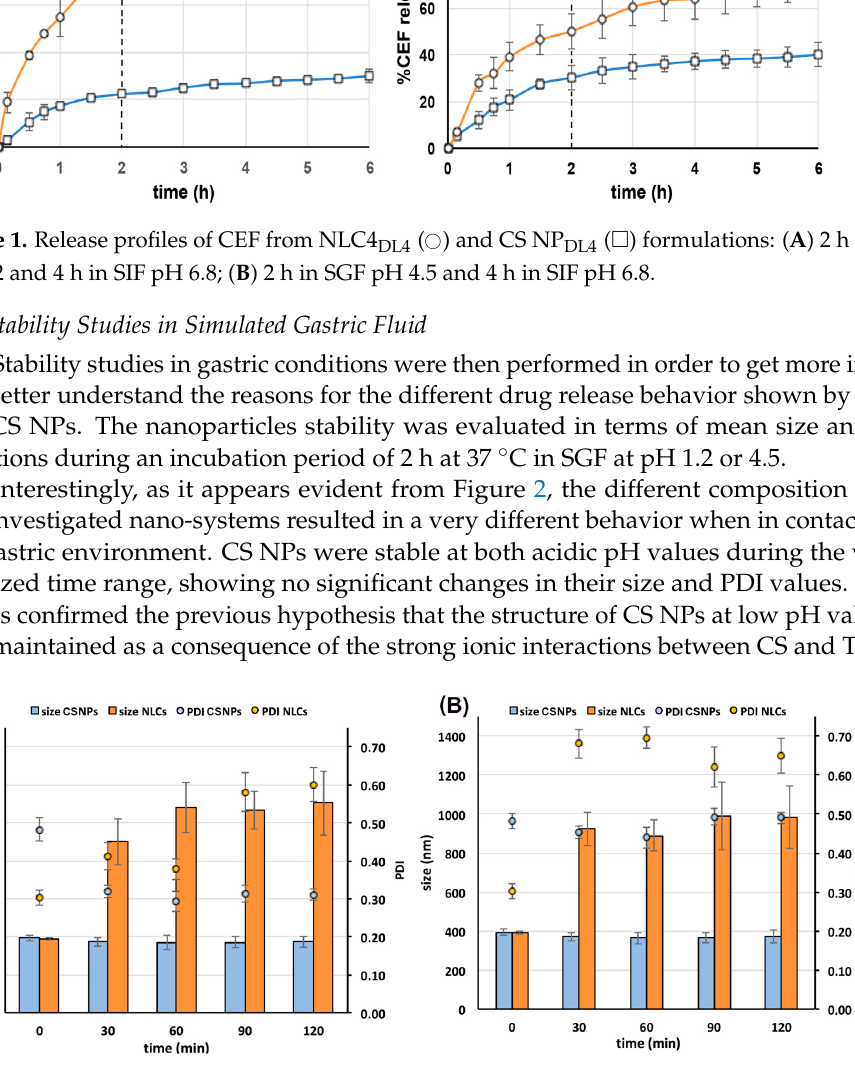
Figure 2. Stability of the selected NLC4 DL4 and CS NP DL4 formulations in SGF at pH 1.2 ( A ) or at pH 4.5 ( B ). pH 4.5 ( B